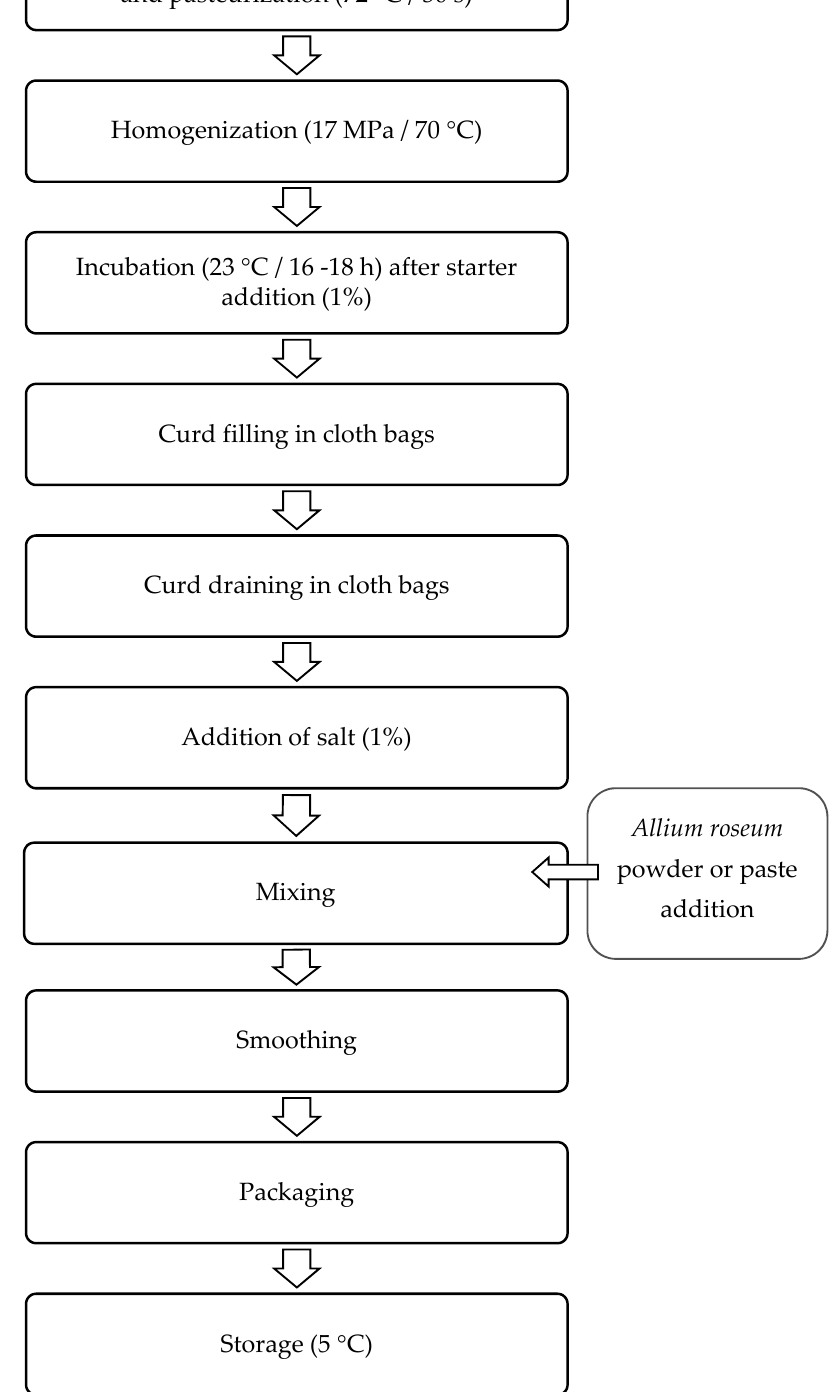
Figure 1. Main processing steps for double cream cheese making.